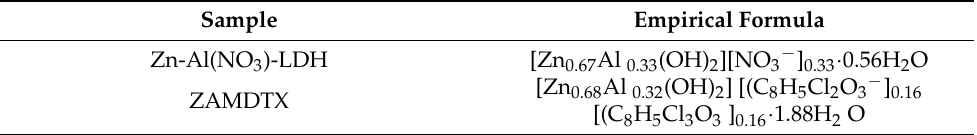
Table 1. Empirical formula and d-spacing of Zn/Al-NO 3 , and ZADTX